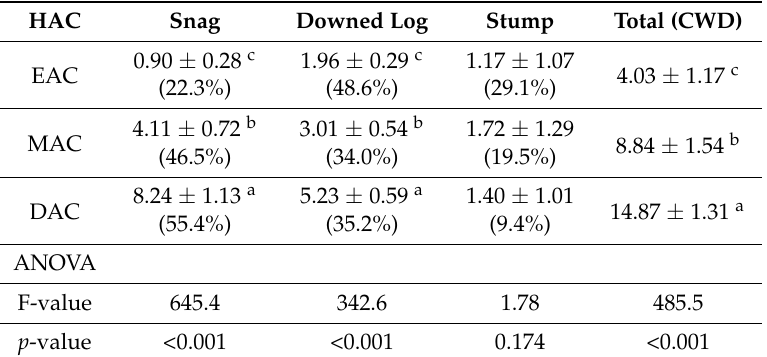
Table 5. Volume (average ± SD) of CWD (m 3 ha − 1 ) components (snag, downed log and stump) in the accessibility classes and results of ANOVA and Tukey HSD tests 1